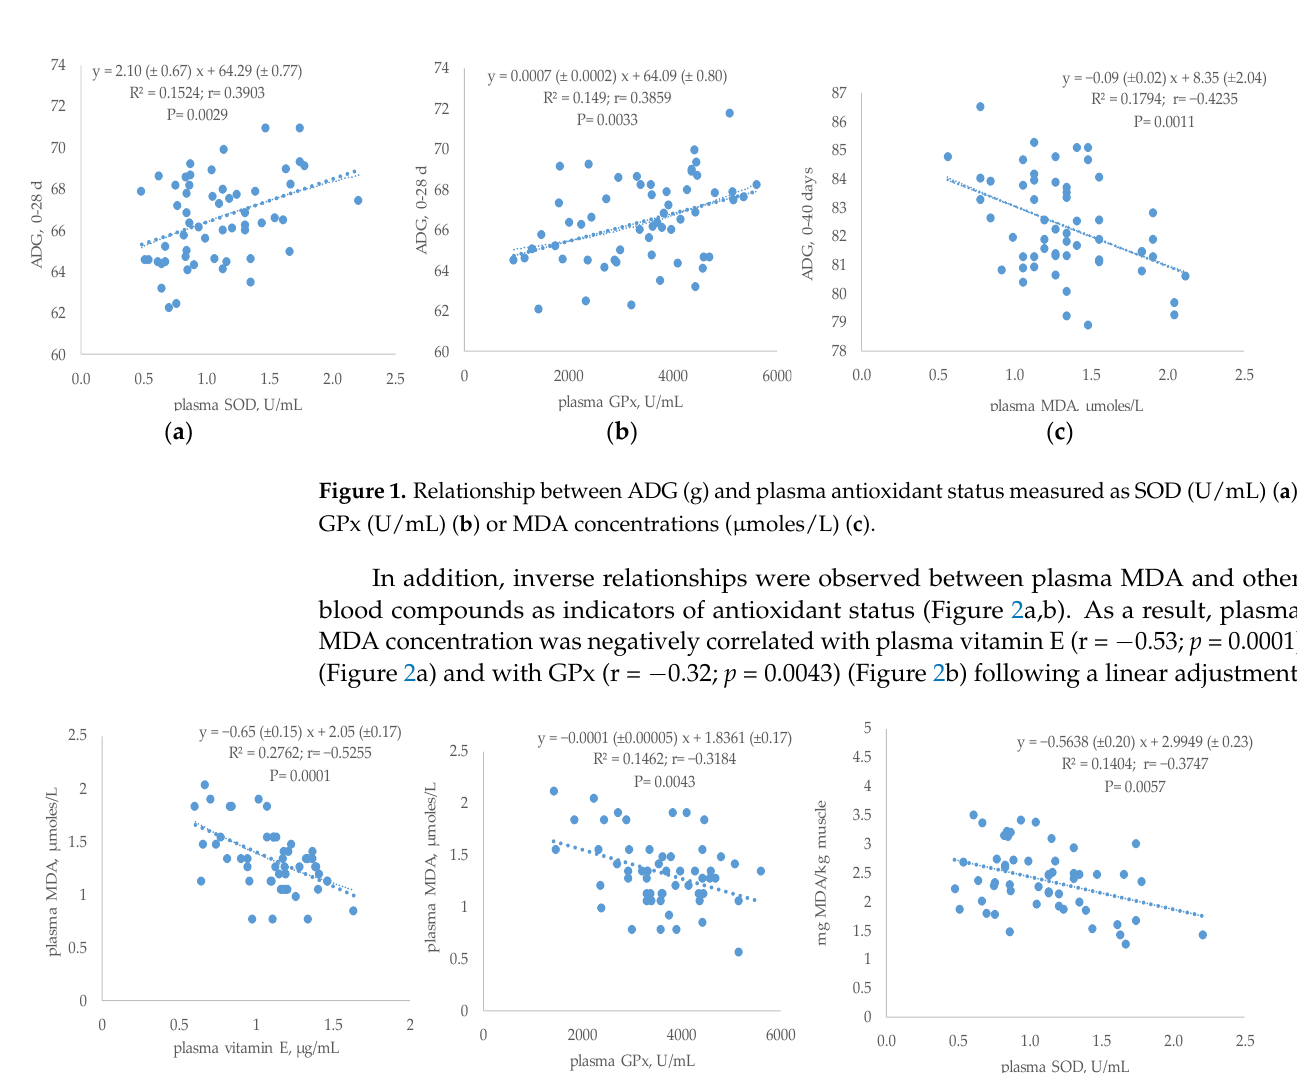
Figure 2. Relationship between plasma MDA (µmoles/L) and plasma vitamin E (µg/mL) ( a ) or GPx (U/mL) ( b ); and between muscle MDA (mg/kg) and plasma SOD ( c ). The relationships between plasma MDA and vitamin E and between muscle MDA The plasma oxidative status was also correlated with breast lipid oxidation (Figure